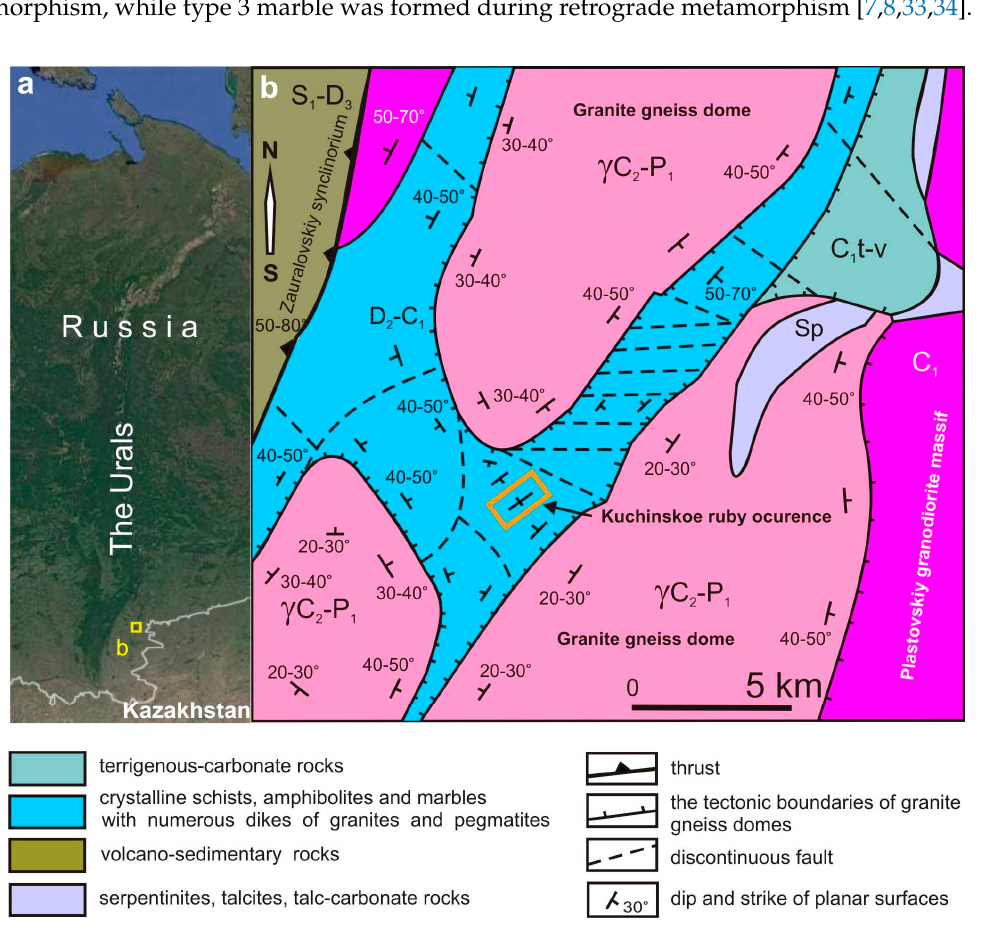
Figure 1. ( a ) The localization of the Kuchinskoe marble-hosted ruby occurrence and ( b ) a schematic geological map of the site.